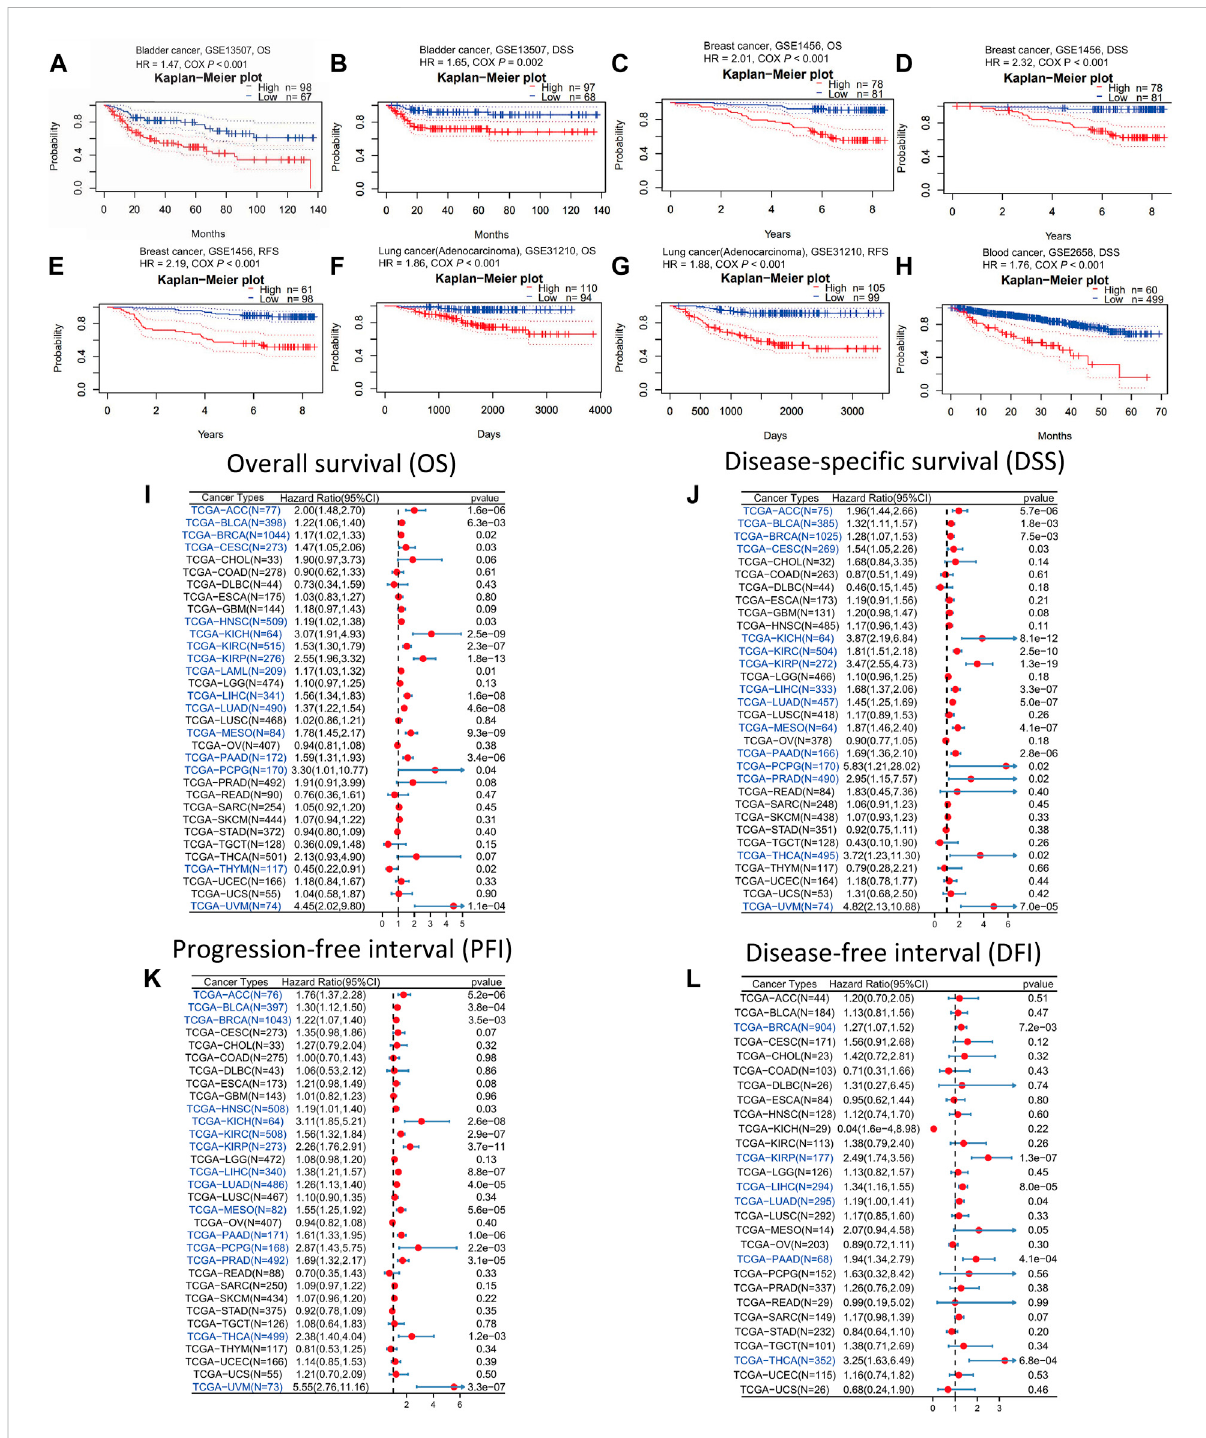
FIGURE 3 Survival analysis of ANLN across different cancer types in the GEO and TCGA datasets. Kaplan-Meier plots of ANLN in eight cohorts including GSE13507, OS (A) ; GSE13507, DSS (B) ; GSE1456, OS (C) ; GSE1456, DSS (D) ; GSE1456, RFS (E) ; GSE31210, OS (F) ; GSE31210, RFS (G) ; GSE2658, DSS (H) . Forest plots demonstrating the relationship between ANLN expression and patient OS (I) , DSS (J) , PFI (K) , and DFI (L) . Statistically signi fi cant results are marked in